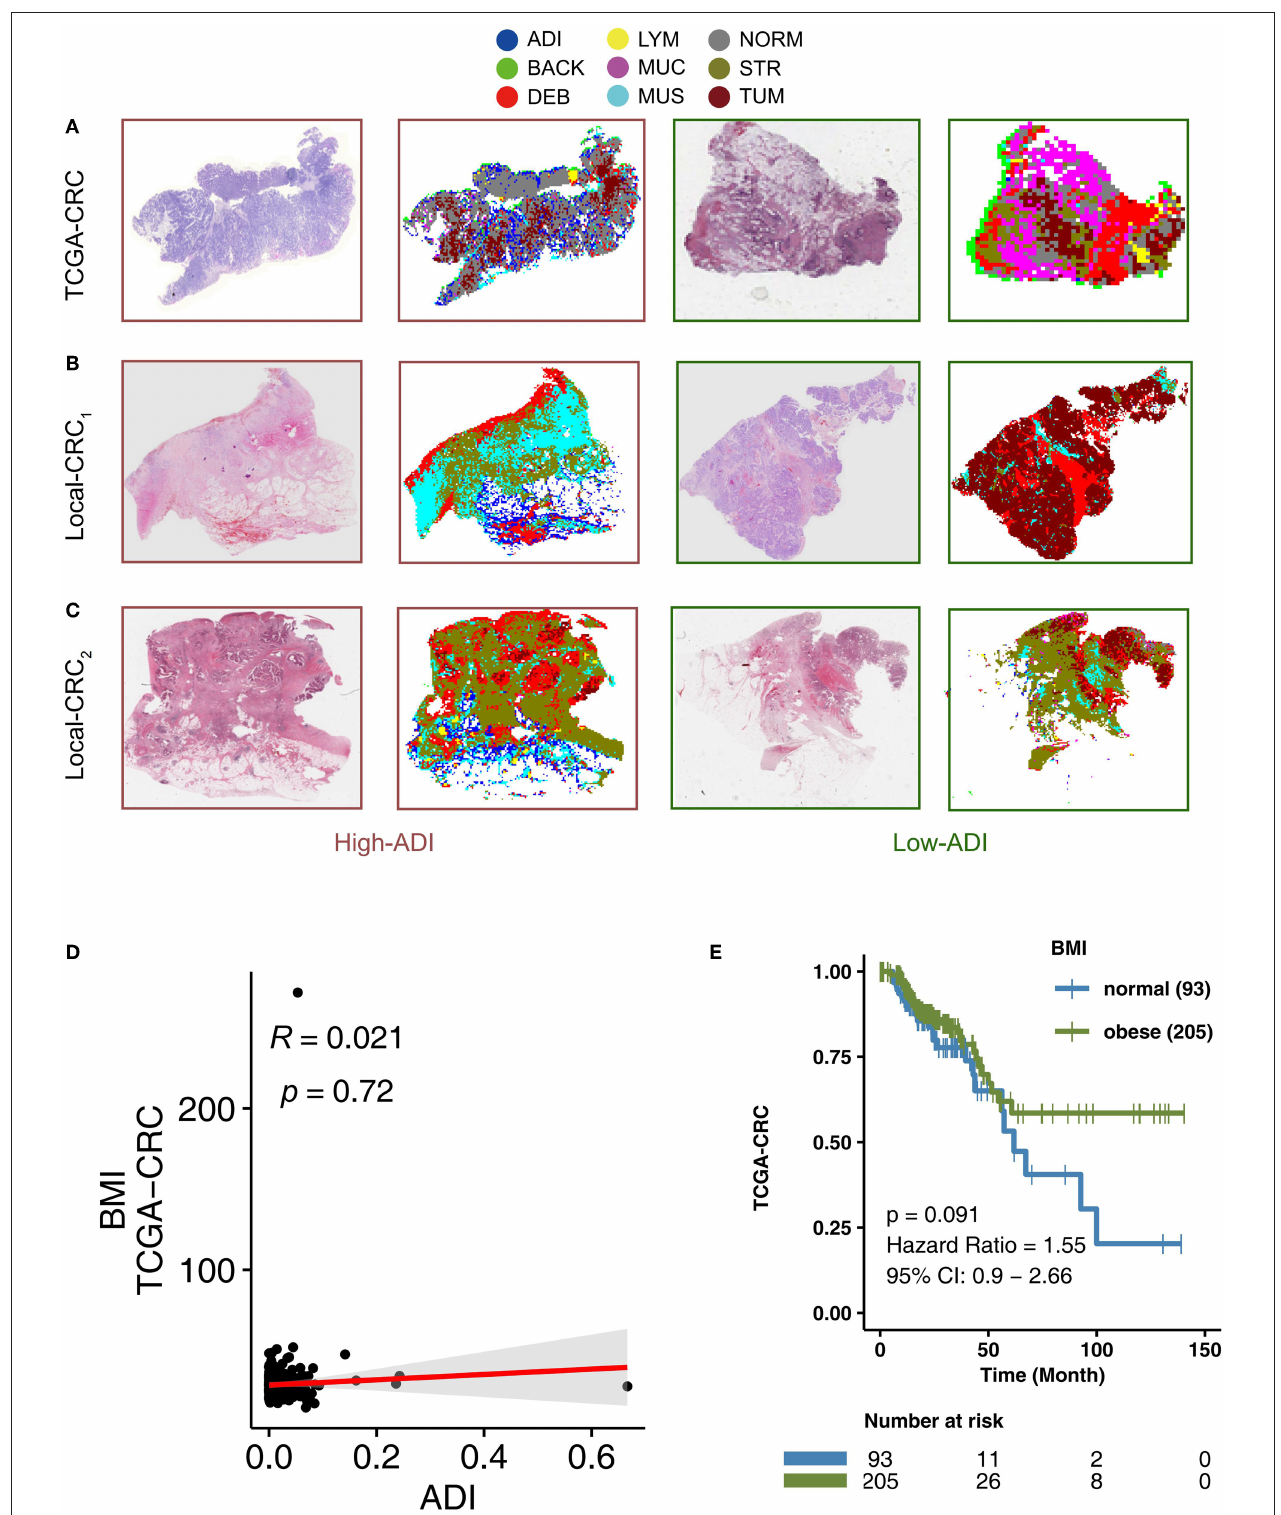
FIGURE 2 | The association between BMI and clinical prognosis of TCGA-CRC patients. Examples of high-ADI and low-ADI H&E-stained WSIs and corresponding segmented results from the TCGA-CRC cohort (A) , Local-CRC1 (B) , and Local-CRC2 (C) . (D) The correlation between BMI and ADI in the TCGA-CRC cohort (Spearman correlation). (E) Overall survival for subjects grouped according to BMI subclass (obese and normal). H&E, hematoxylin–eosin; WSI, whole-slide image; and ADI, adipose.